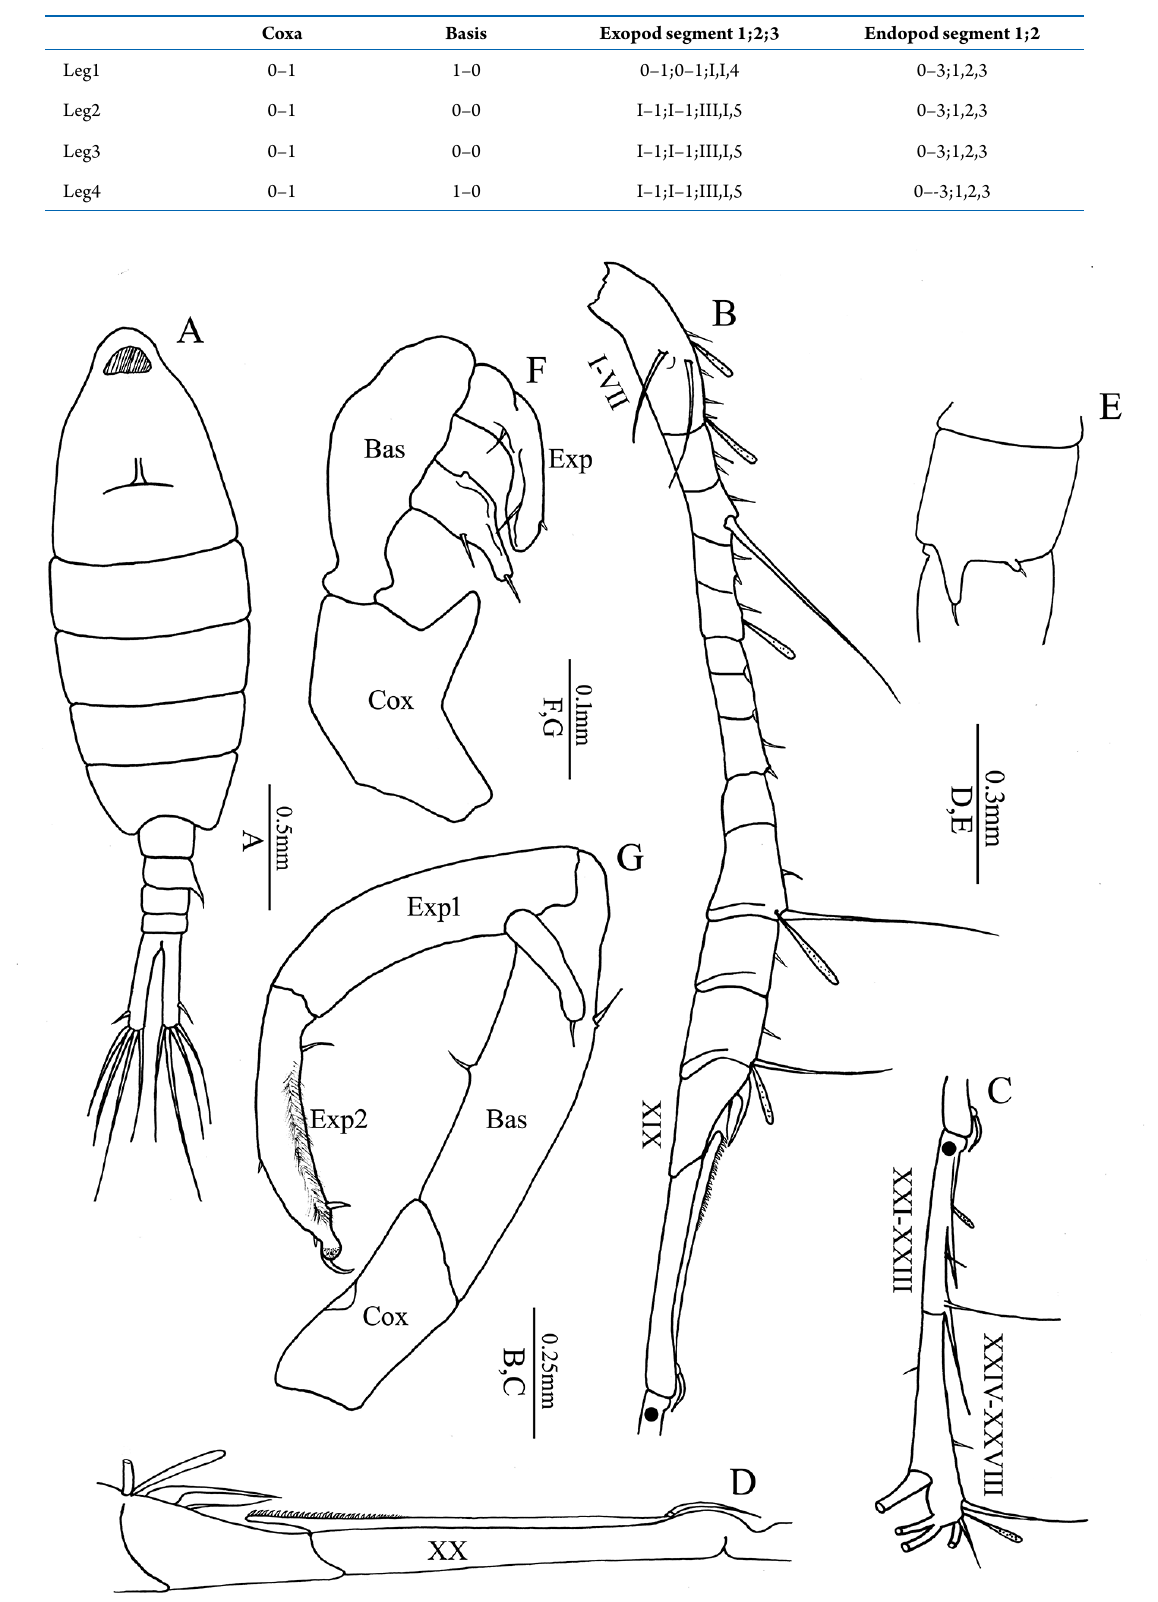
Table 1. Seta (in Arabic numerals) and spine formula (in Roman numerals) of legs 1–4 of female Tortanus ( Atortus ) dhritiae sp. nov.